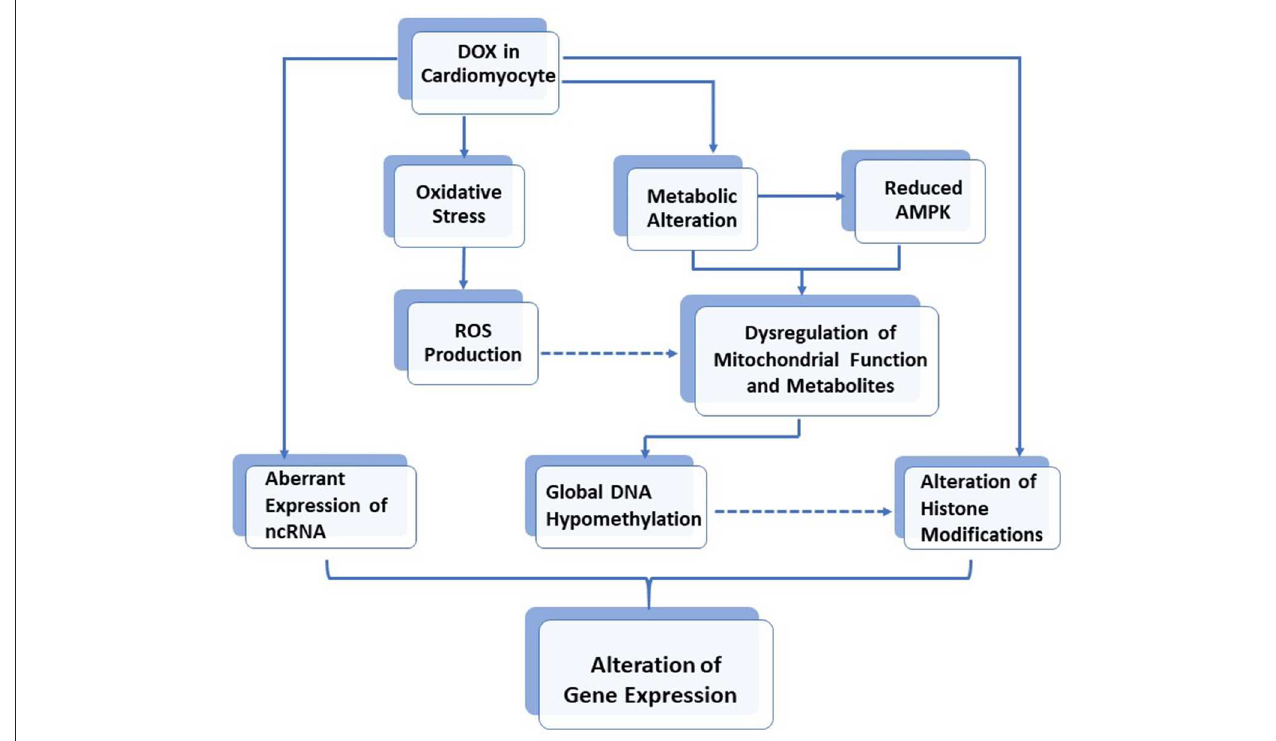
FIGURE 1 | The role of DOX in alteration of gene expressions via epigenetic modifications in cardiomyocytes.